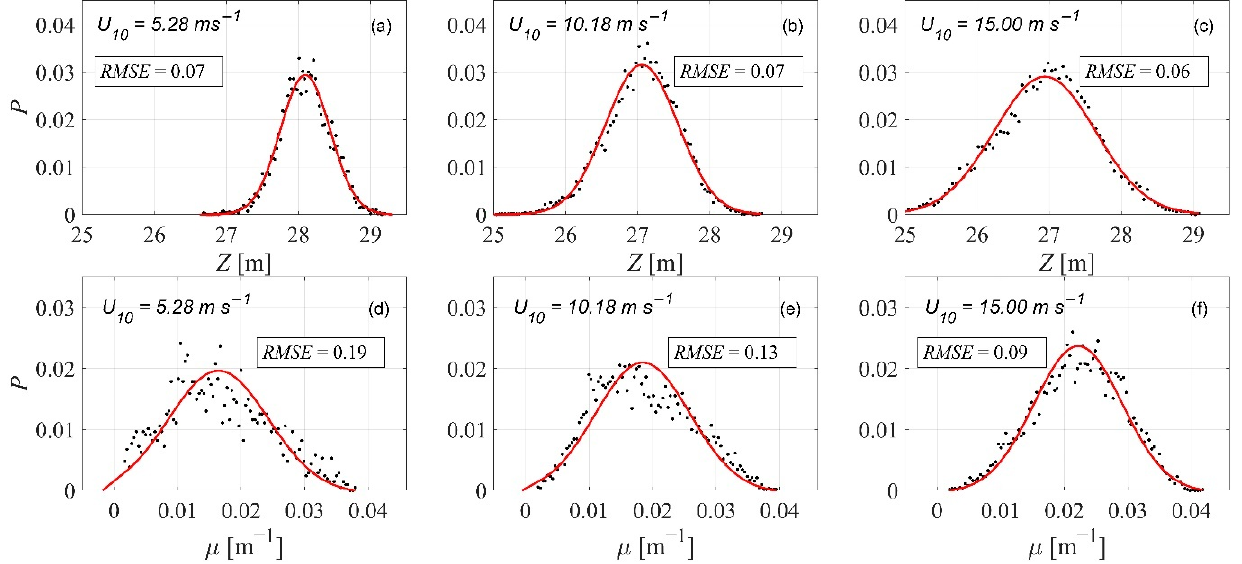
Figure 6. Examples of the probability density distribution of the laser range, Z, ( a – c ), and the laser intensity attenuation coefficient, 𝜇 ( d – f ) under various wind conditions. Red solid lines are Gaussian regression fitting to experimental samples for a 5 m s − 1 , 10 m s − 1 and 15 m s − 1 wind speed event, respectively. The root mean square error RMSE was utilized to evaluate the performance of the fitting.